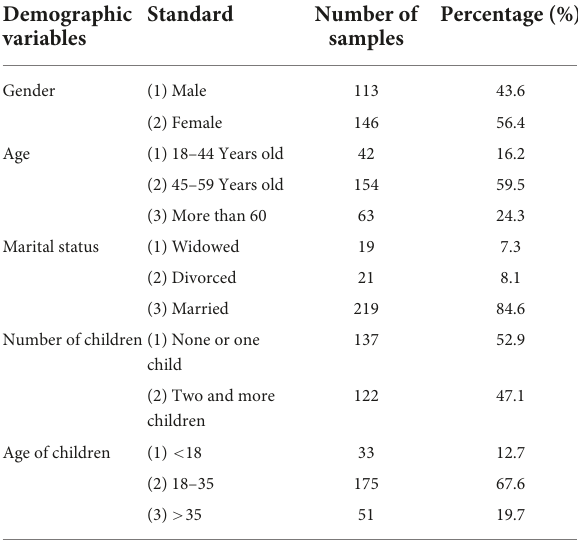
TABLE 1 Basic information of the participants in a valid